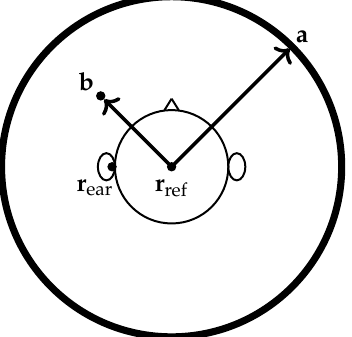
Figure 2. Geometry for near-field HRTF